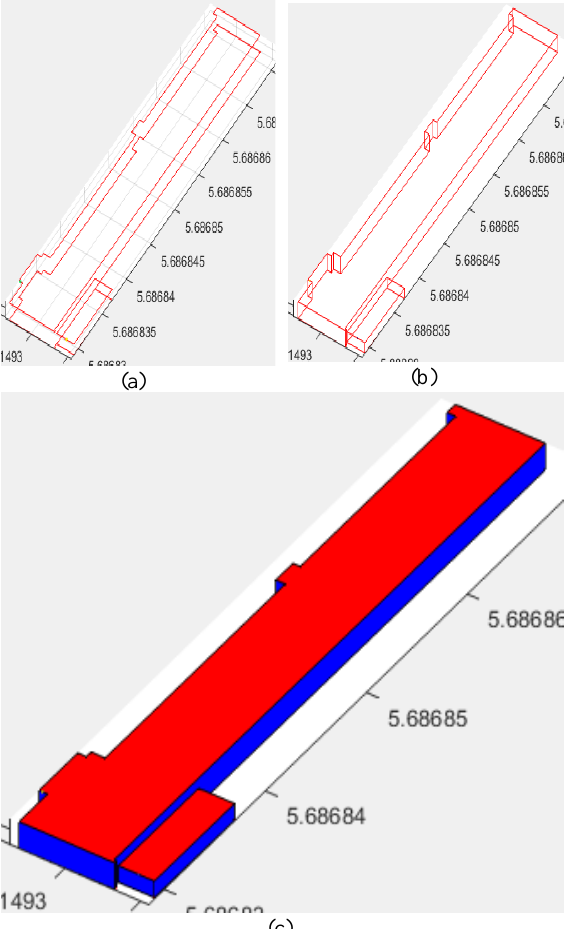
Figure 7. a) Projected roof edges and corners on the